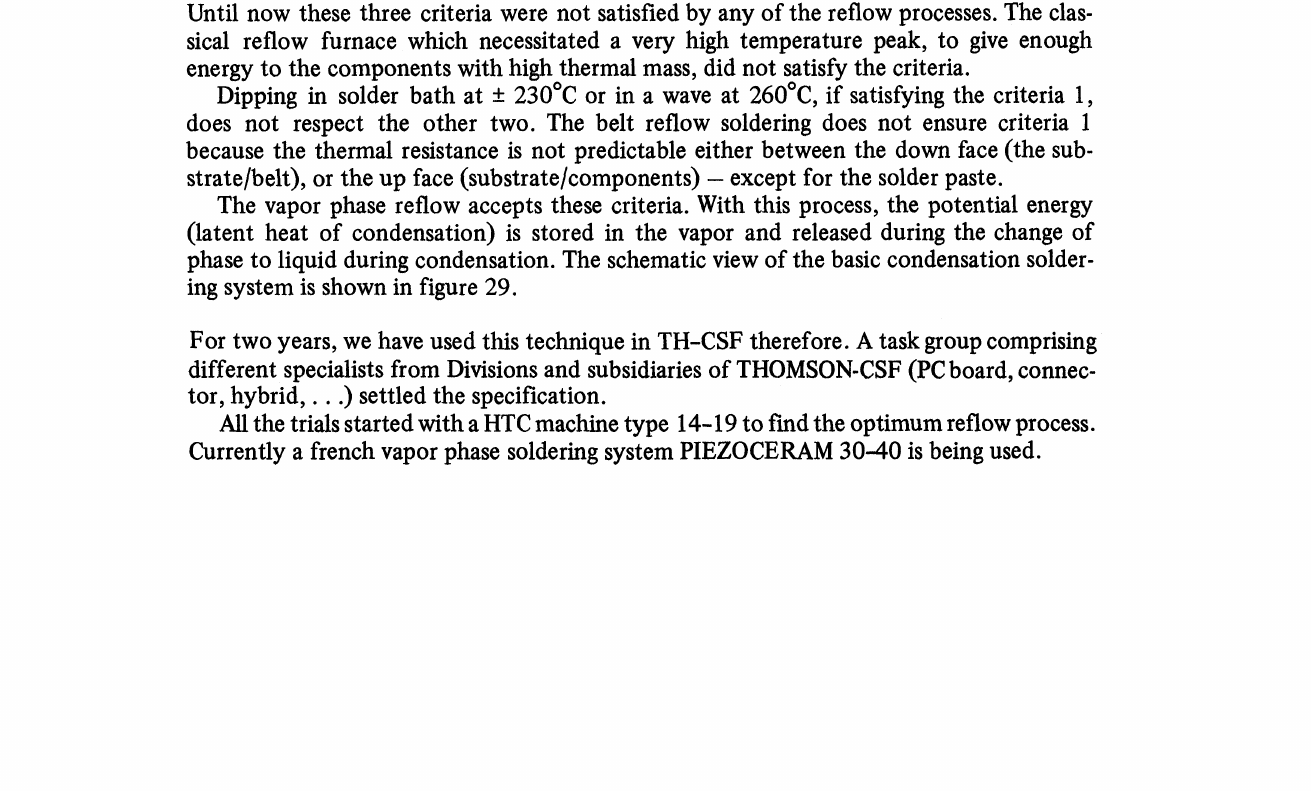
FIGURE 28 Au, X-ray mapping after 1000 h at 125C.